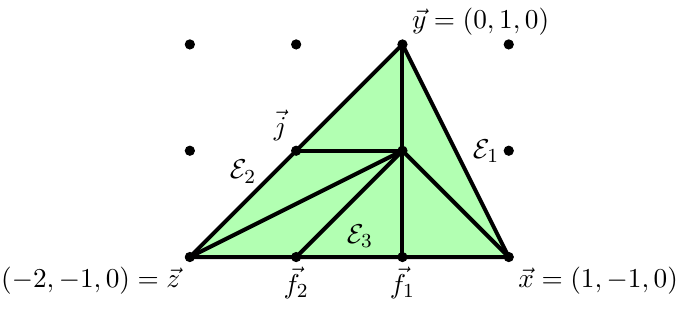
Figure 3 . Toric diagram of F 10 with blow-ups on the edges. The vertices ( ~x; ~y;~z ) give rise to bi-, tri-, and rational sections, respectively, of the elliptic (cid:12)bration. The SU(2) singularity over f s 4 = 0 g is resolved by j , and the SU(3) over f s 8 = 0 g is resolved by f 1 and f 2 . The edges of length l are labelled by E l